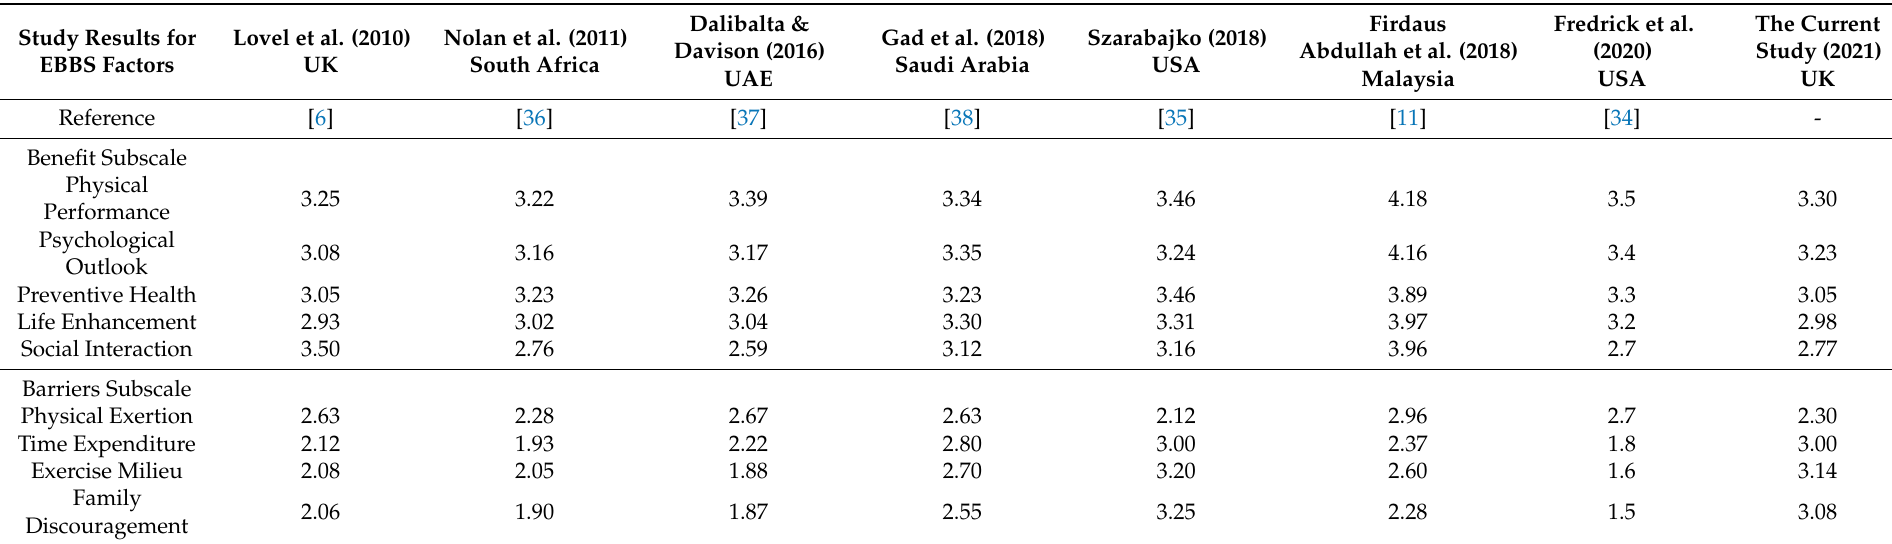
Table 9. Comparison of the subscale means of perceived benefits and barriers of the physical activity as reported in the current study compared with the previous studies with comparable methodology and